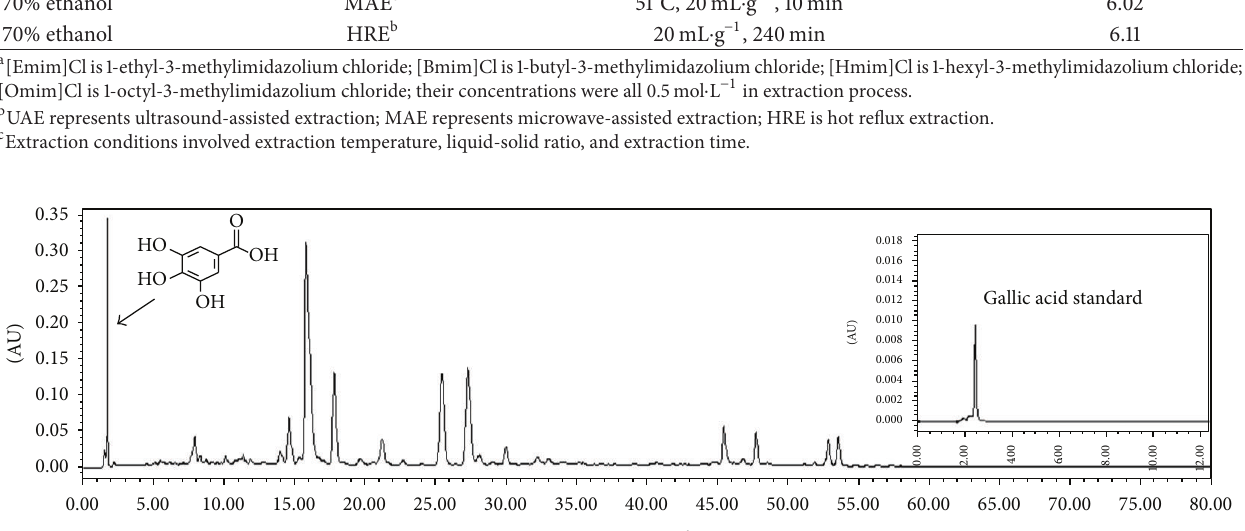
Figure 3: High performance liquid chromatography profile using 0.5 mol ⋅ L −1 [Hmim]Cl as solvent under the operation conditions of 51 ∘ C extraction temperature, 20 mL ⋅ g −1 liquid-solid ratio, and 42min